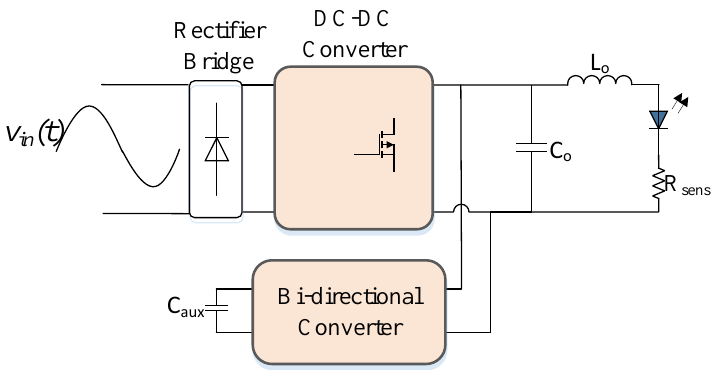
Figure 2 . Parallel type of ripple cancellation circuit diagram [19]. Figure 2. Parallel type of ripple cancellation circuit diagram